Question: Write a single sentence explaining what this figure depicts.
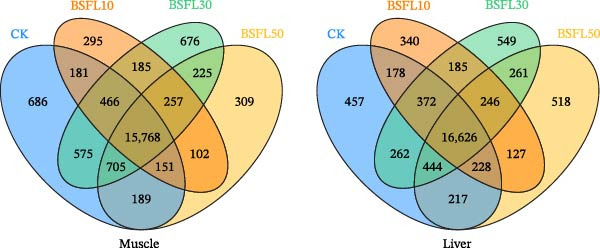
Answer: Venn diagram showing the number of transcripts in muscle, liver, and intestine of juvenile hybrid grouper‐fed different diets by comparing two contrasts.